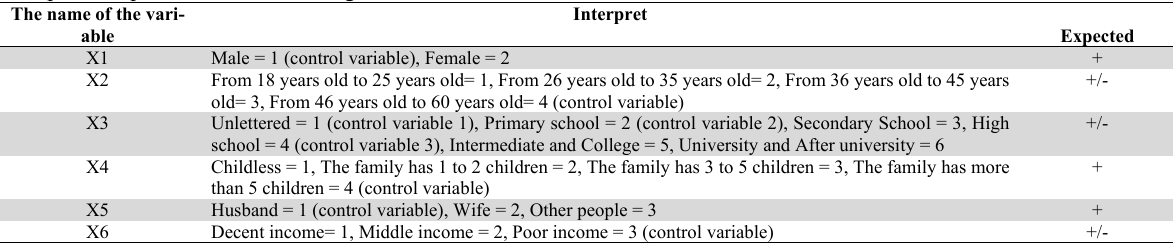
Interpret independent variables in regression models The name of the vari- able